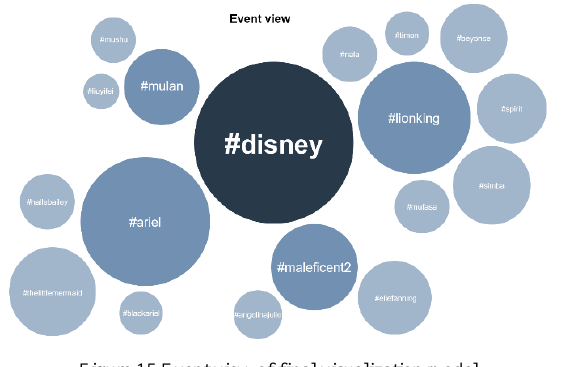
Figure 15 Event view of final visualization model